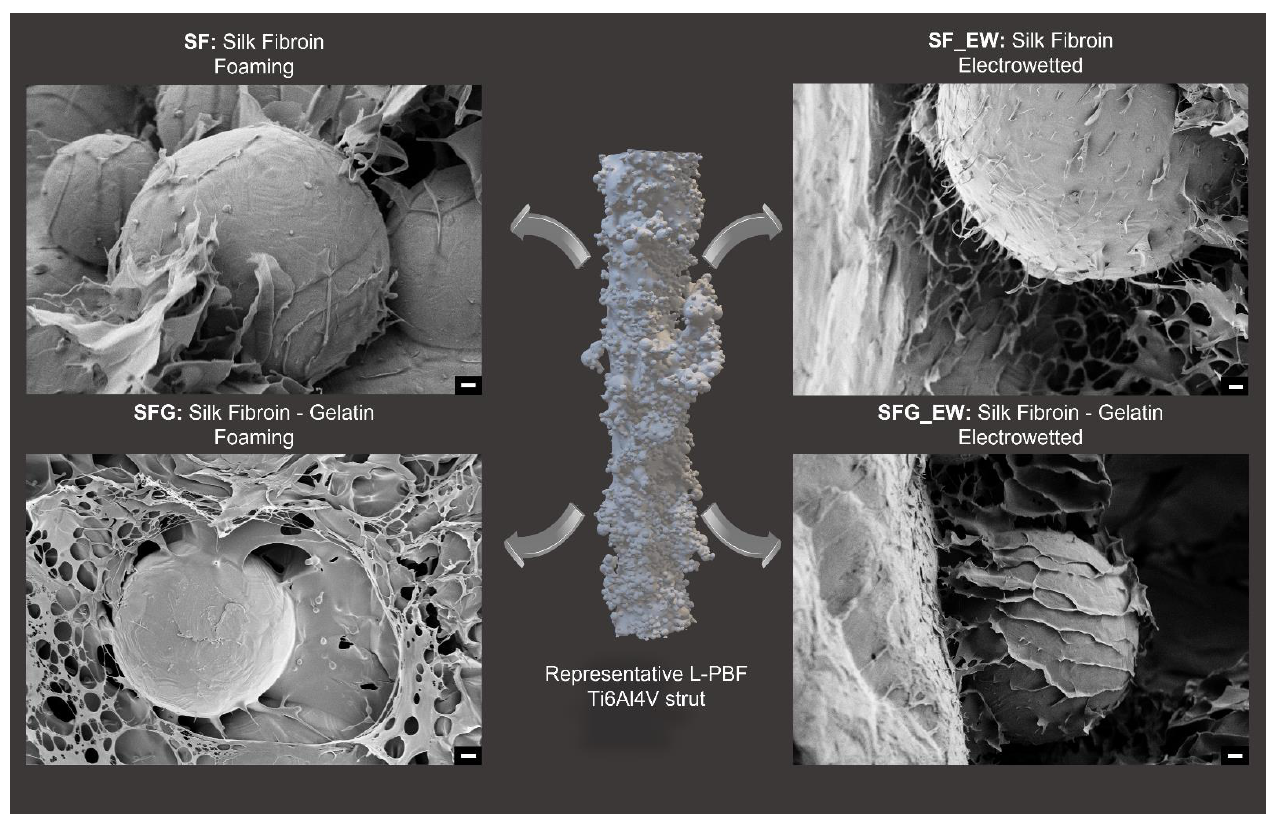
Figure 5. A representative close-up of the FE-SEM images of the four composite specimens at the metal-polymer interface were attached with a representative 3D reconstruction of a single strut of the LPBF Ti6Al4V lattice structure. The four FE-SEM images represent the silk fibroin foamed (SF) composite specimens (top-left), the silk fibroin electrowet (SF_EW) composite specimens (top-right), the silk fibroin/gelatin foamed (SFG) composite specimens (bottom-left), and the silk fibroin/gelatin electrowet (SFG_EW) composite specimens (bottom-right). Scale bars were set to 2 µm for all four images.